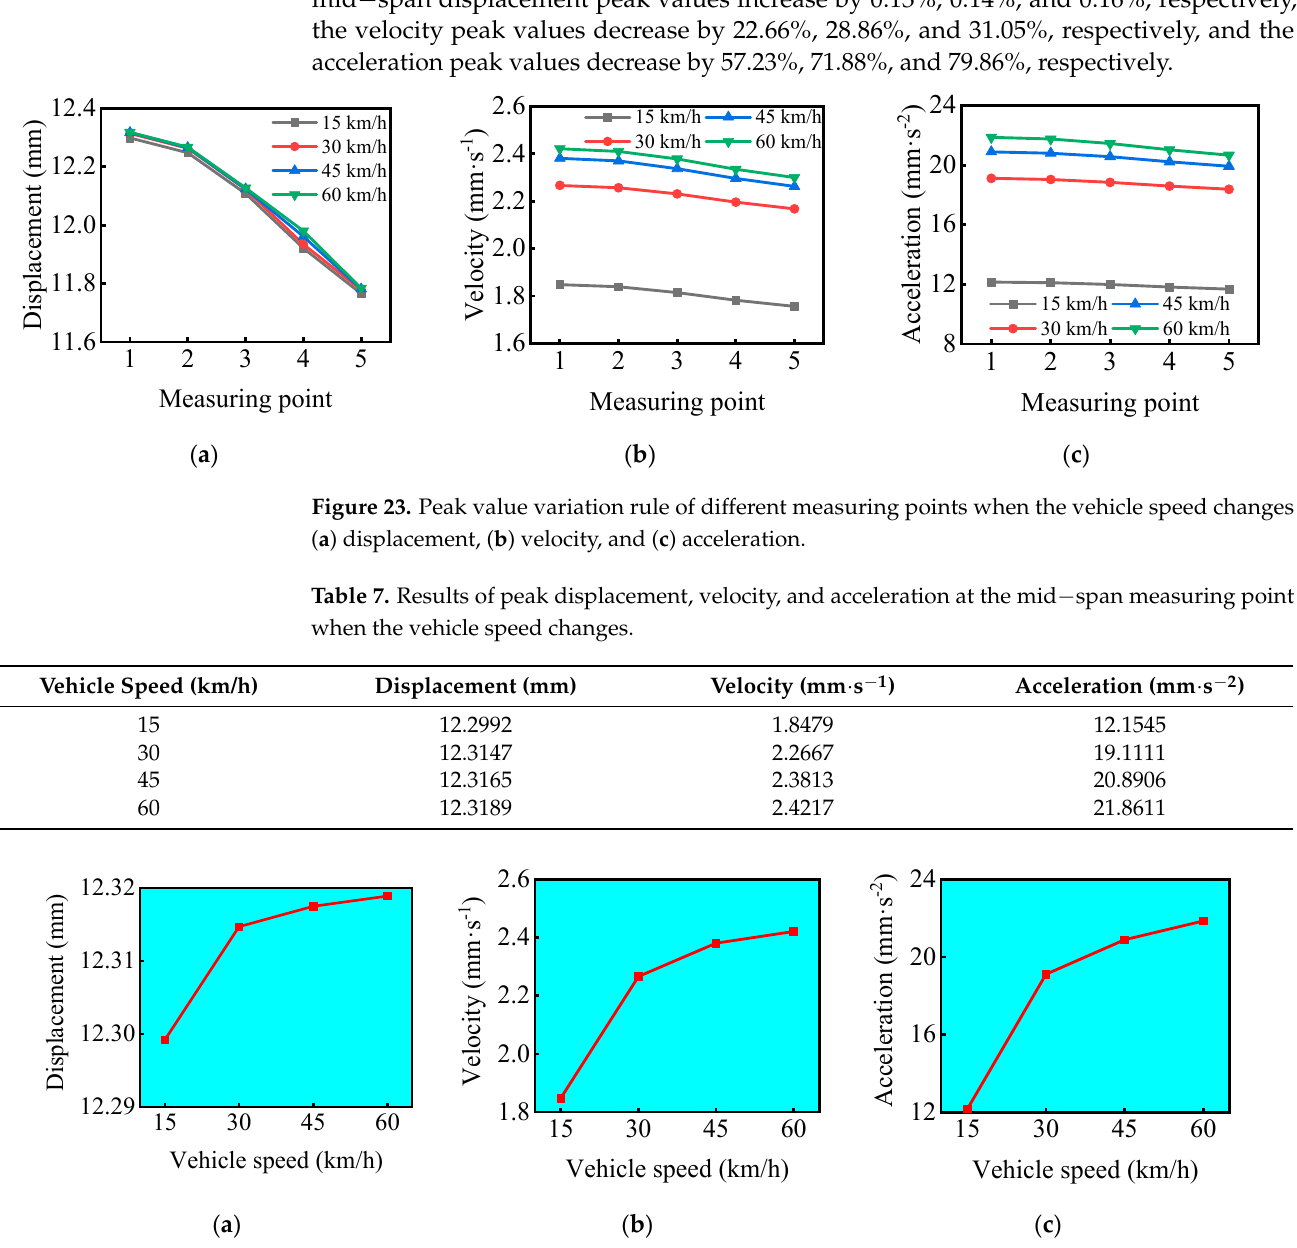
Table 7. Results of peak displacement, velocity, and acceleration at the mid − span measuring point when the vehicle speed changes.